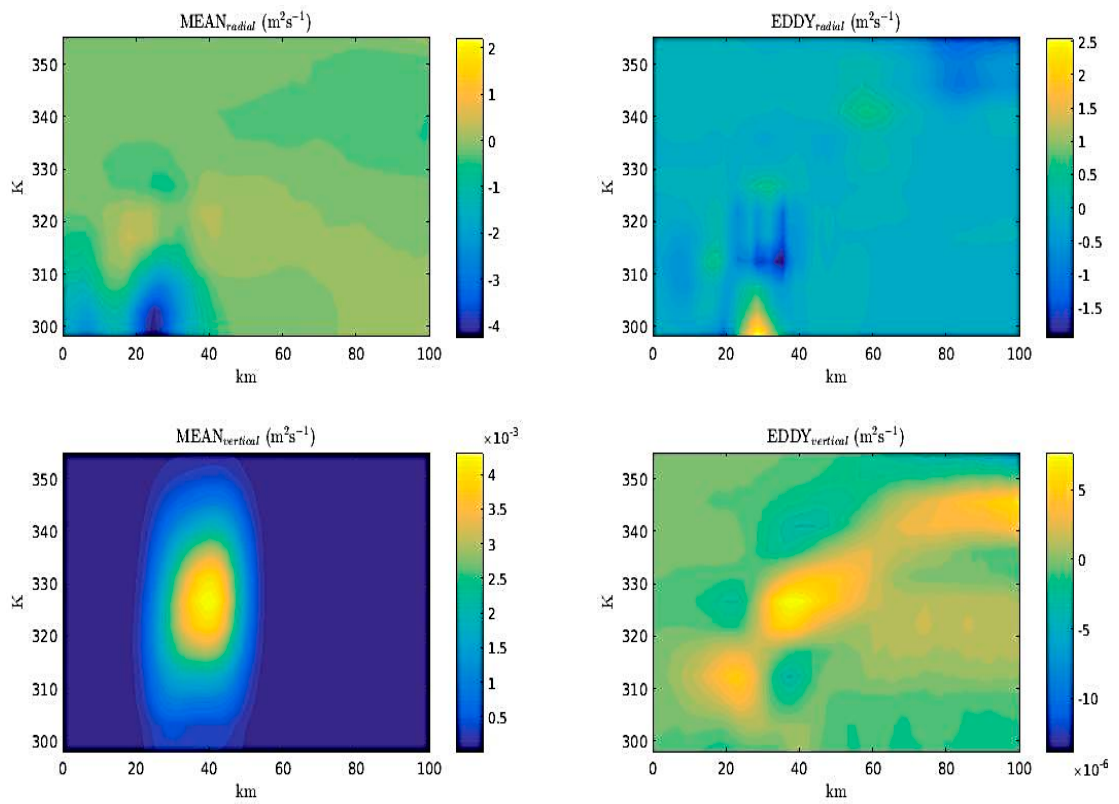
Figure 10. Same as Figure 9, except for (cid:1872) = 36 h